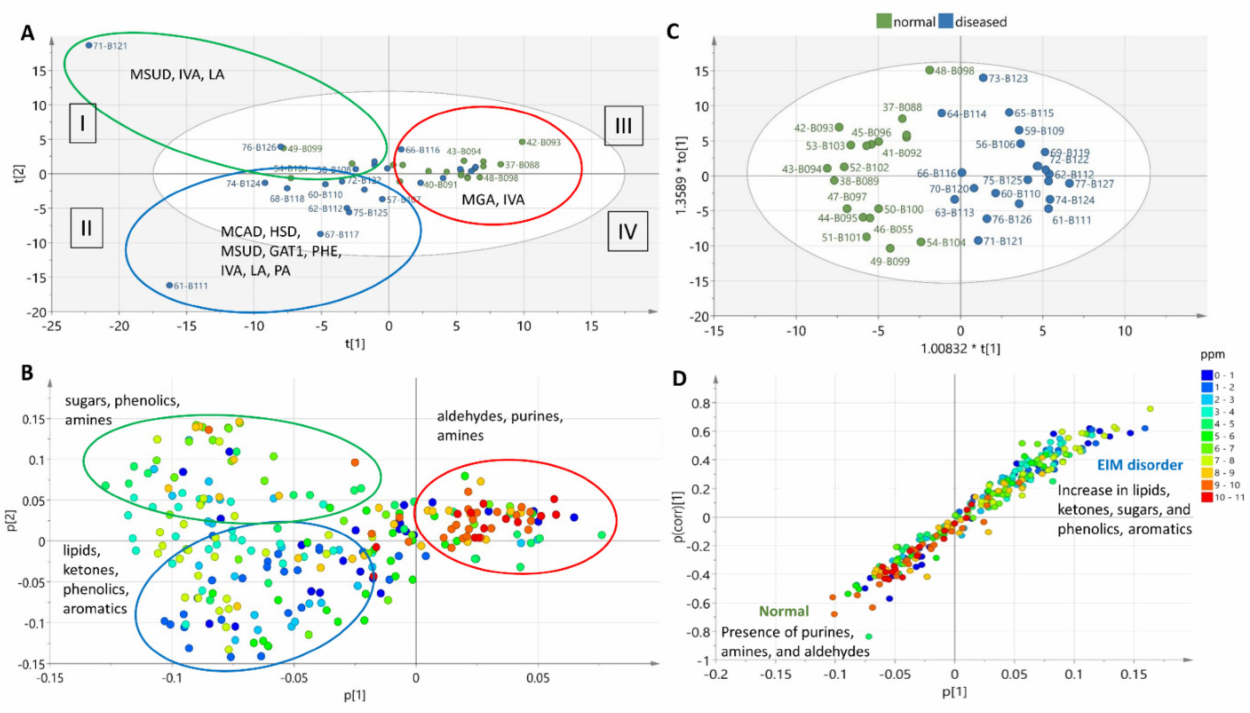
Figure 3. Multivariate analysis of 1 H-NMR spectral data of healthy samples vs. those with diagnosed IEM disorders. ( A ) PCA scores plot, ( B ) PCA loadings plot, ( C ) OPLS-DA scores plot, and ( D ) OPLS-DA loadings S-plot. Legend: propionic acidemia (PA), isovaleric acidemia (IVA), medium chain acyl-CoA dehydrogenase deficiency (MCAD), 3-methylglutaconic acidemia (MGA), holocarboxylase synthetase deficiency (HSD), glutaric acidemia type I (GAT1), lactic aciduria (LA), maple syrup urine disease (MSUD), and disorders of phenylalanine metabolism